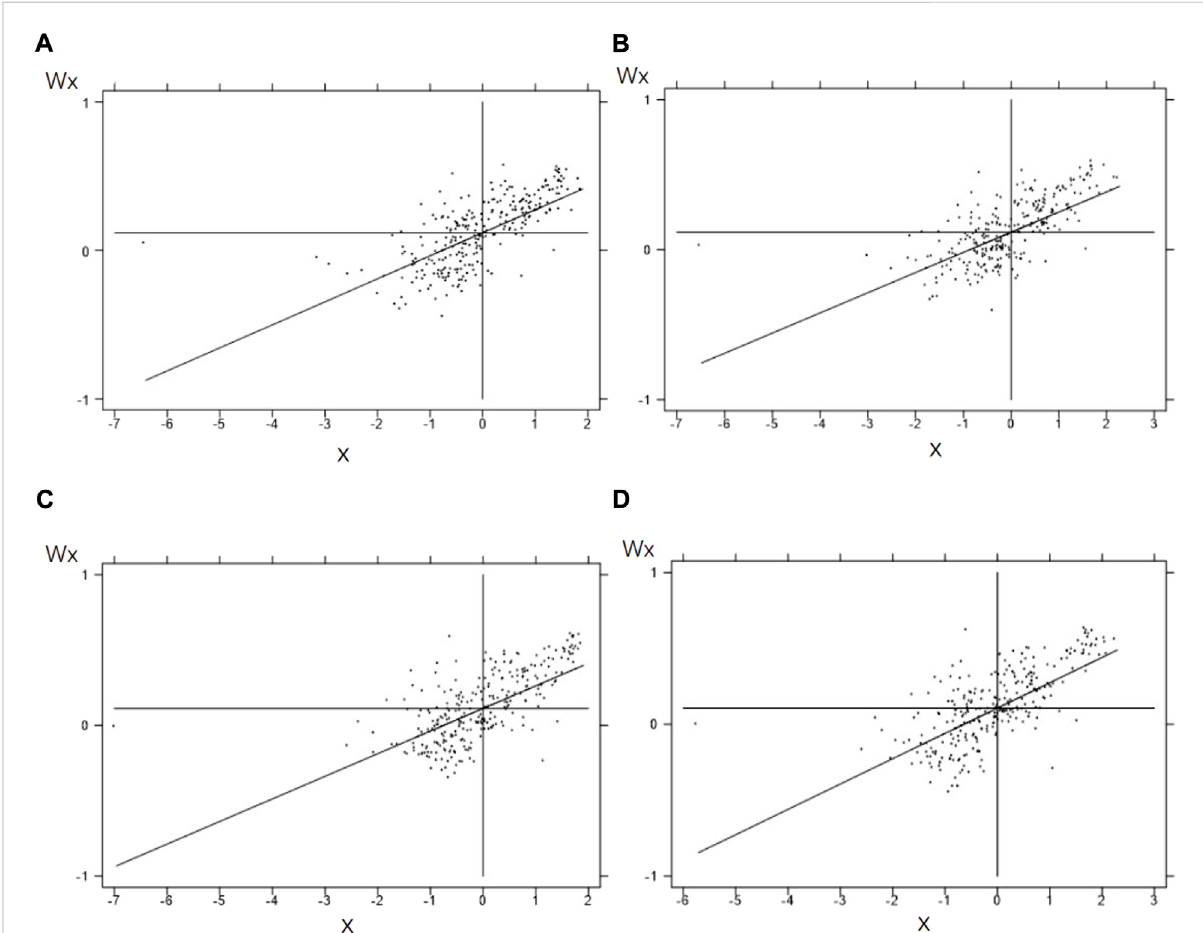
FIGURE 2 Moran ’ s index scatter plots of PM2.5 in Chinese cities. (A) PM2.5 in 2010. (B) PM2.5 in 2013. (C) PM2.5 in 2016. (D) PM2.5 in